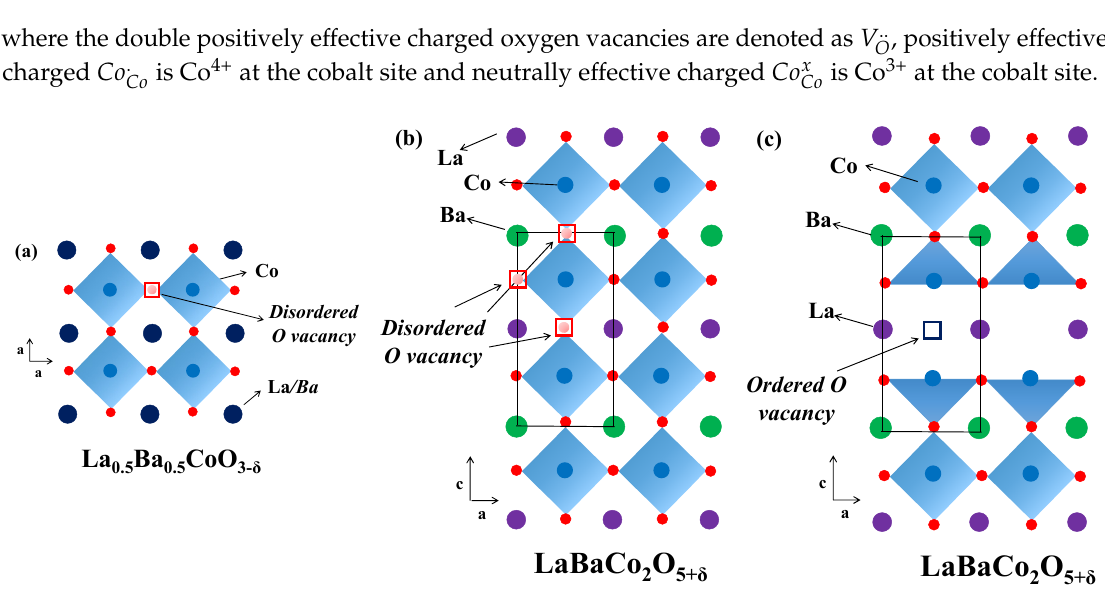
Figure 8. Crystal structure representation of: ( a ) cubic Pm 3 m single perovskite La 0.5 Ba 0.5 CoO 3 ´ δ ; ( b ) tetragonal P4/mmm A-site cation ordered and oxygen vacancy disordered LaBaCo 2 O 5 ´ δ ; and ( c ) orthorhombic Pmmm both A-site cation and oxygen vacancy ordered LaBaCo 2 O 5 ´ δ . Dark blue circles are indistinguishable La/Ba atoms, violet balls are La atoms, green balls are Ba atoms, light blue balls are Co atoms, red balls are oxygen, disordered oxygen vacancies are red squares and ordered oxygen vacancies are violet squares.